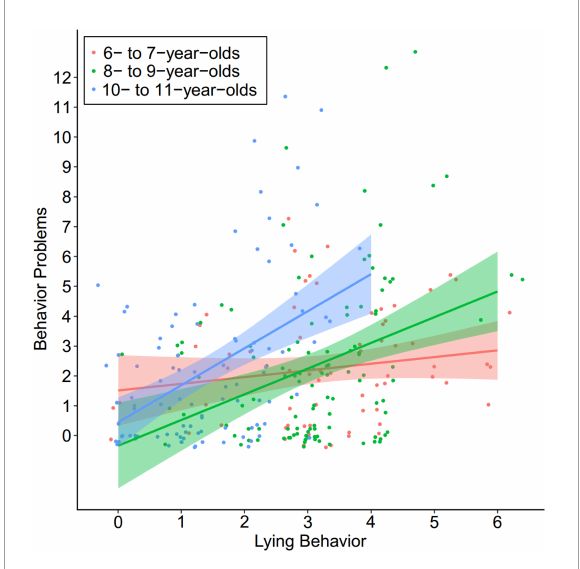
FIGURE1 Relation between children’s lying and their behavior problems (jitter plot with fitted line and 95%